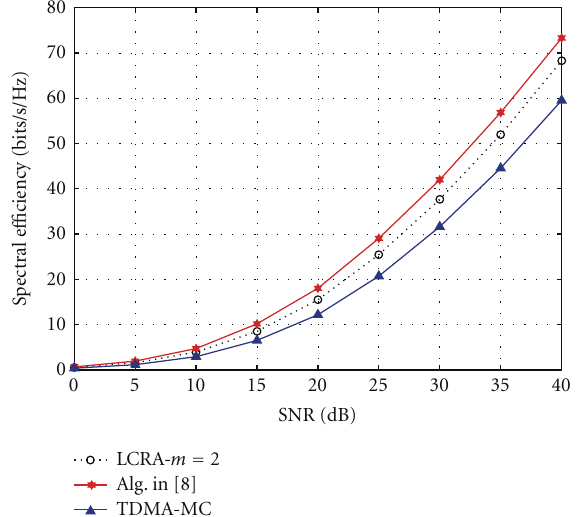
Figure 11: Spectral e ffi ciency versus SNR—pathloss di ff erence be- tween MGs.